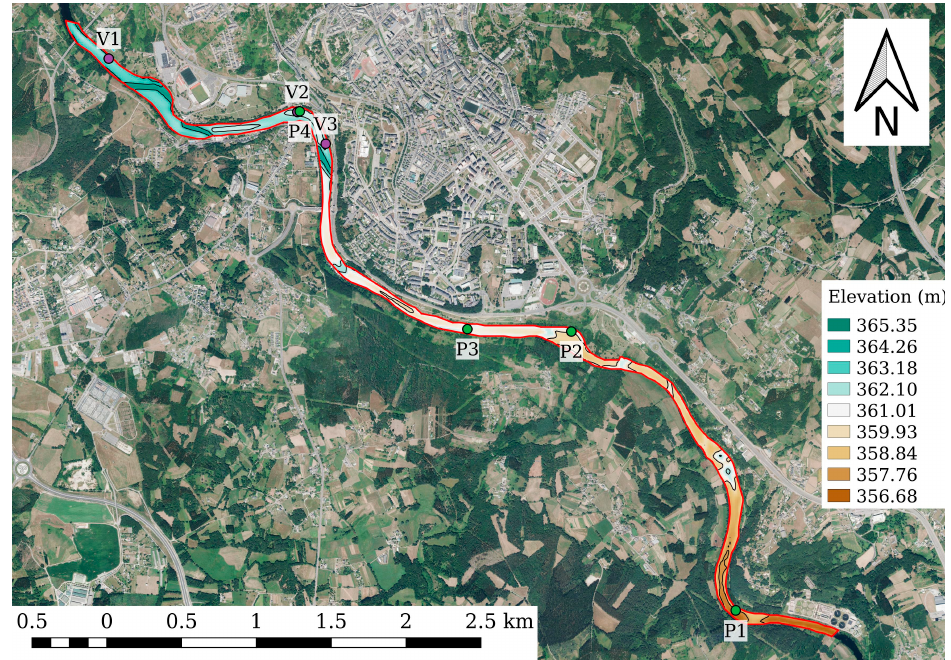
Figure 9. Bathymetry of the Miño River as it passes through the city of Lugo (NW, Spain). The sewage spills are located at points V1, V2 and V3. The control points are located at P1, P2, P3 and P4.